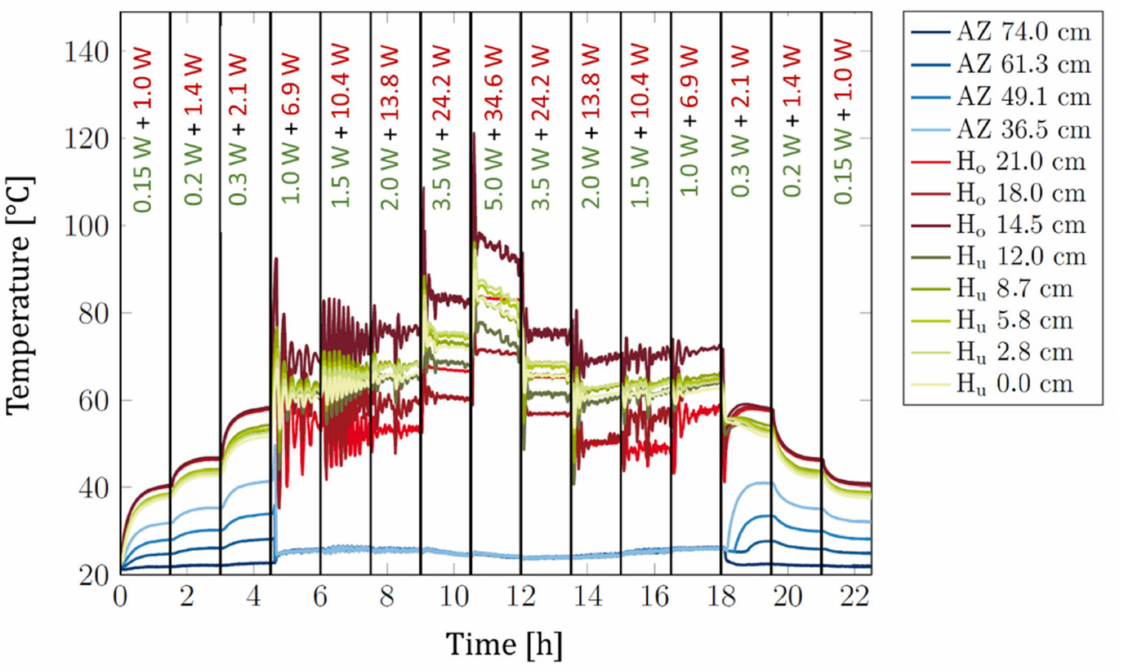
Figure 8. Siphon-2 with 4 g of sorbent: Temperatures measured along the heat switch at different positions (as indicated in the legend) versus time for a constant heat power density ratio 10. Blue lines: Temperatures in adiabatic zone (AZ). Red lines: Temperatures in top heater area (H o ). Green lines: Temperatures in bottom heater area (H u ). The used heat powers are indicated below the upper x -axis. Green number: Total heat power of bottom heater. Red number: Power of top heater. Each set of heat powers was held for 90